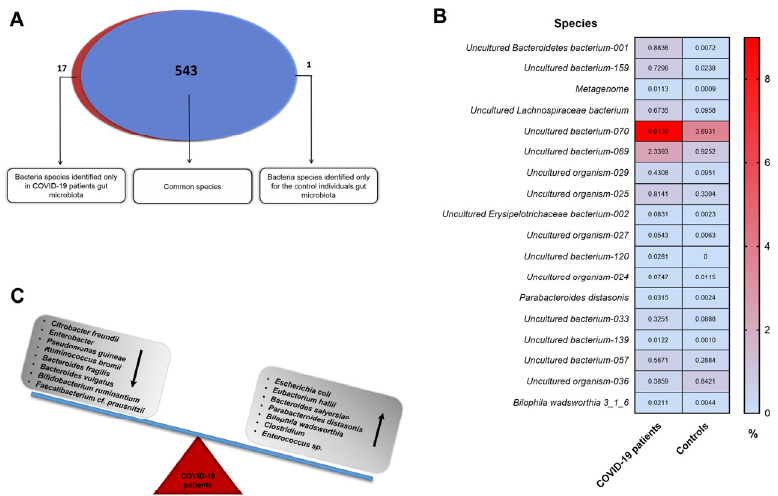
Figure 6. Species abundance distribution and difference in microbial composition between COVID-19 patients and healthy controls. ( A ) Venn diagram for identified in the study gut microbiota species. Red and blue represent COVID-19 patients and healthy controls data, respectively. The intersection shows the species (543) shared with both groups. ( B ) Heatmap of abundance differences in studied group at species level (mean values). These data only concern initial statistically significant results calculated using the non-parametric Mann–Whitney. ( C ) Observed multiple differences in the amount of bacteria abundance ( ↓ —reduction, ↑ —increase) between COVID-19 patients’ microbiota compared to healthy controls.